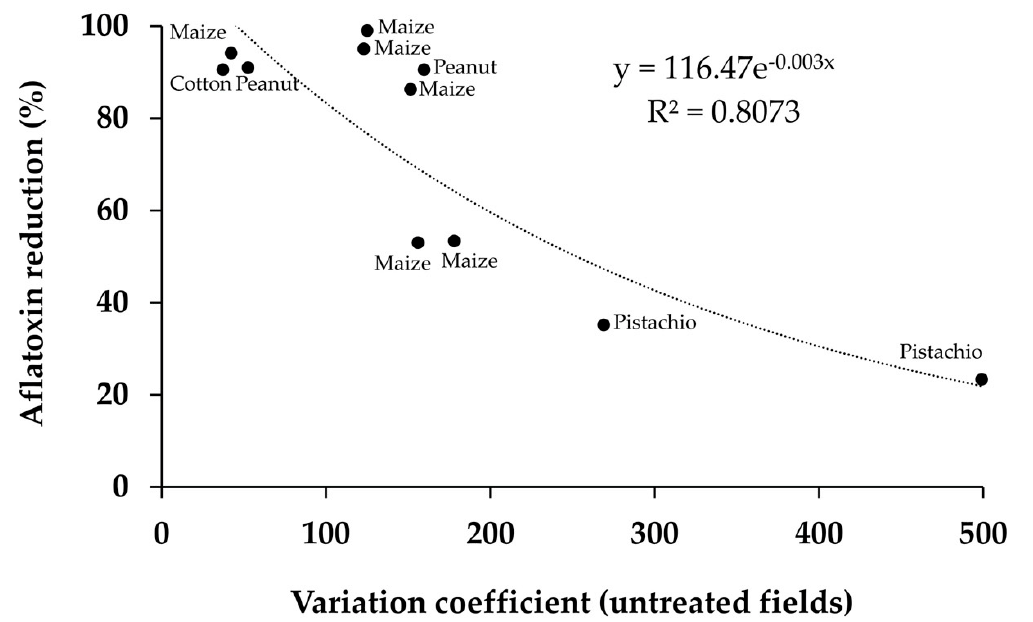
Figure 3. Relationship between aflatoxin reduction (%) as a result of application of atoxigenic Aspergillus flavus isolates to different commodities and the variation coefficient of aflatoxin contamination found in untreated fields of these crops.